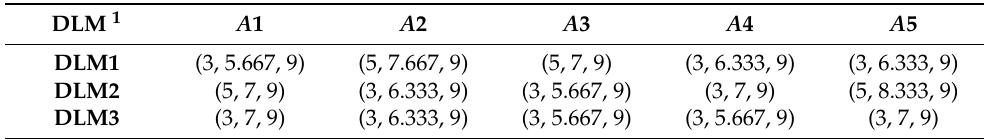
Table 4. Combined decision matrix for three distance learning course structure assessment by five criteria.